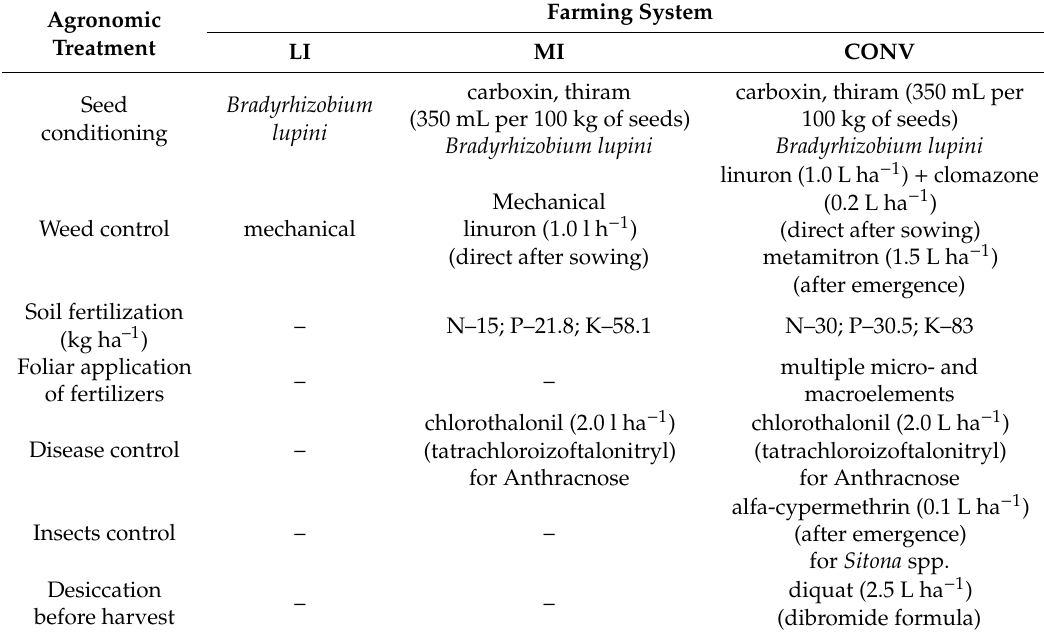
Table 2. Characteristics of the farming systems evaluated in this